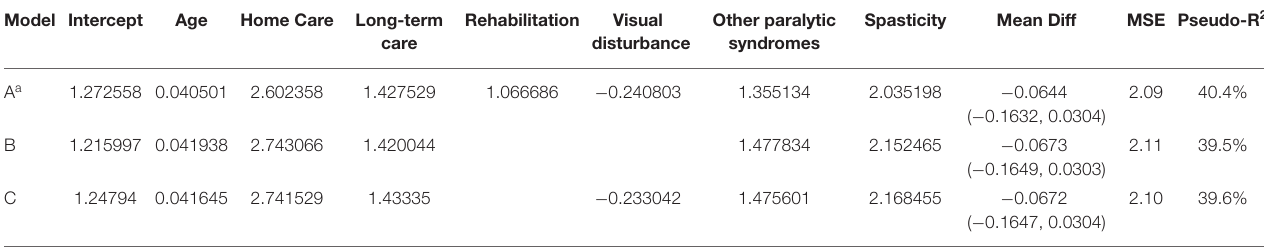
TABLE 4 | Truncated regression-based algorithms for disability as a continuous variable.